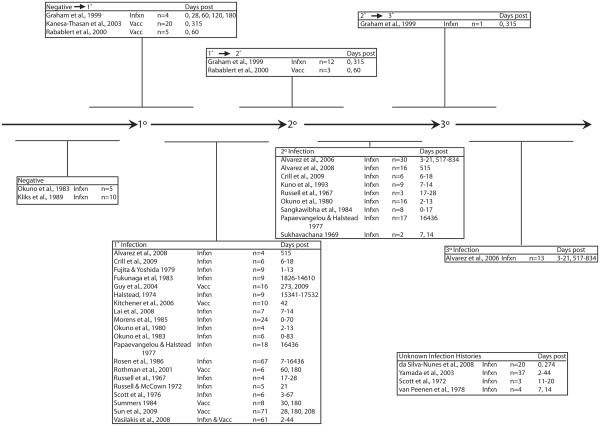
Dengue virus (DENV) exposuretimeline of PRNT titersincluded in this review. Articles above the timeline reported transitions between exposure states while articles below reported single states. 1°, 2°, and 3° abbreviate primary, secondary, and tertiary exposures; “n” indicates the numbers of individuals who contributed titers that met inclusion and exclusion criteria; “Days Post” indicates the number of days between DENV exposure and serum collection.